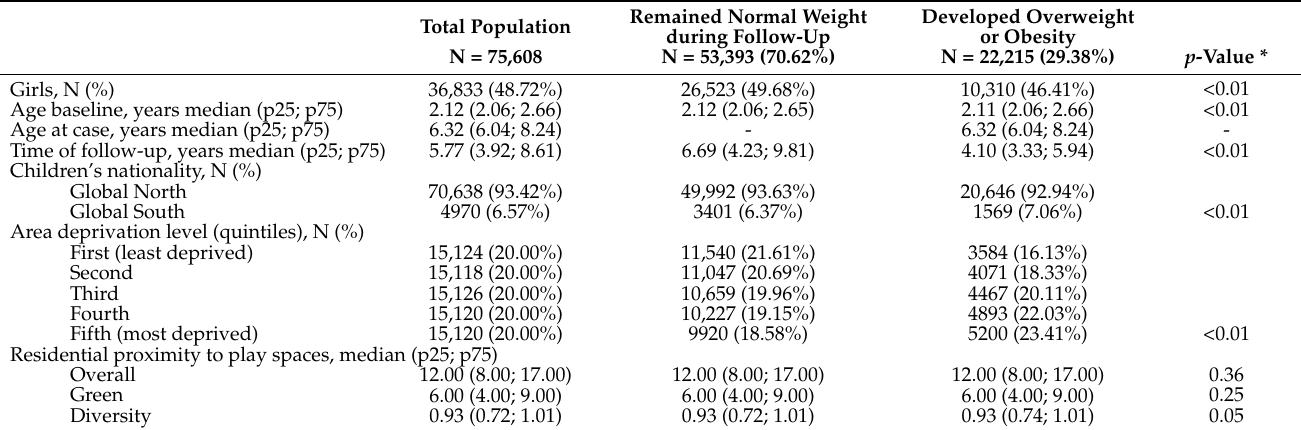
Table 1. Descriptive characteristics of the study population (N = 75,608).